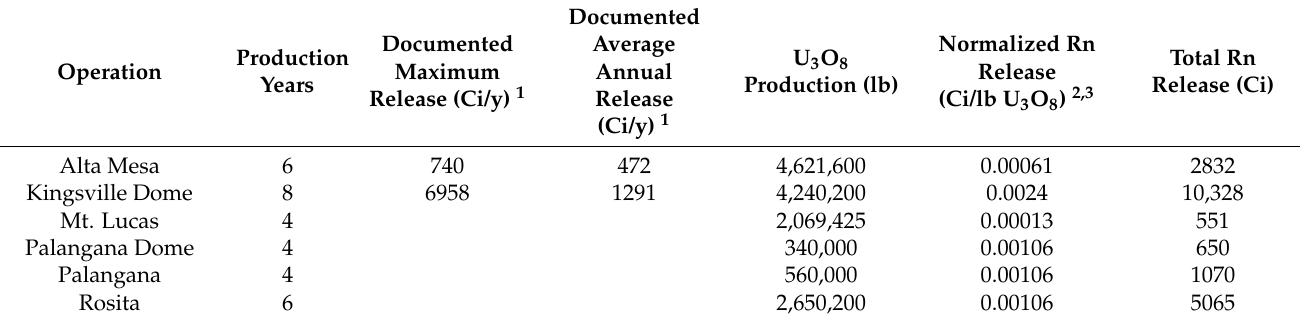
Table A7. Radon releases at ISR facilities.